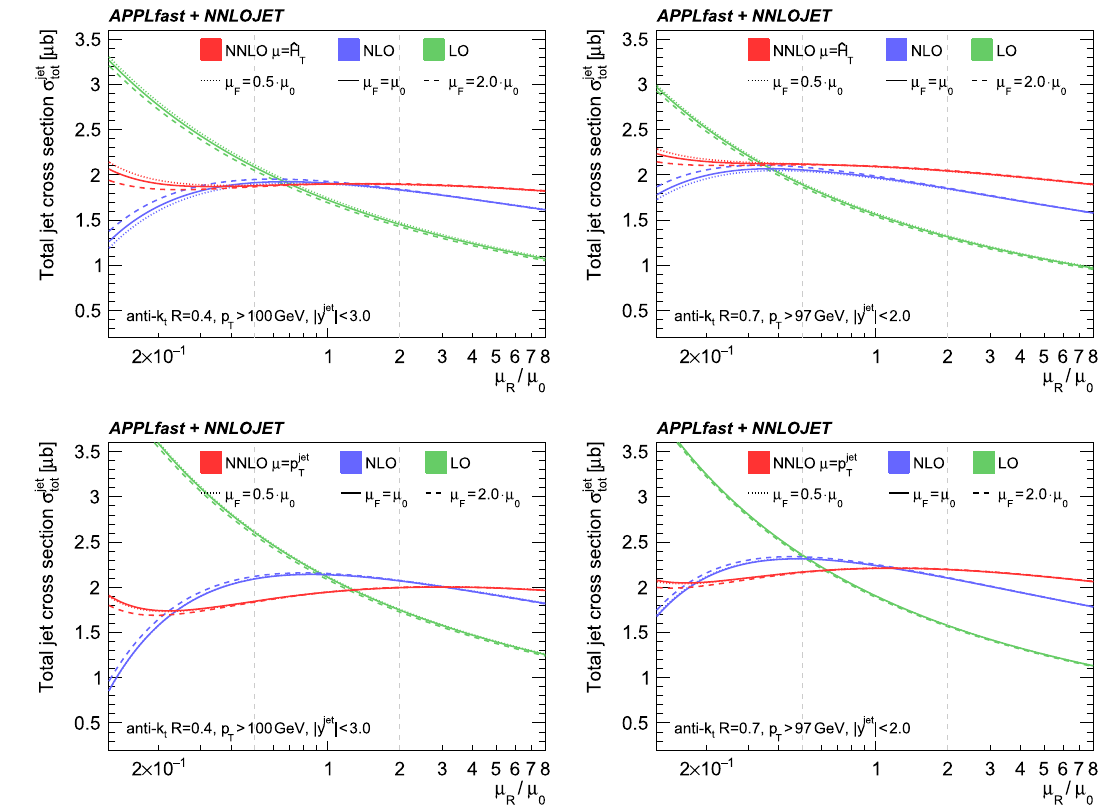
√ s = 13TeV for R = 0 . 4 (left column) and R = 0 . 7 (right column) anti- k T jets. The T